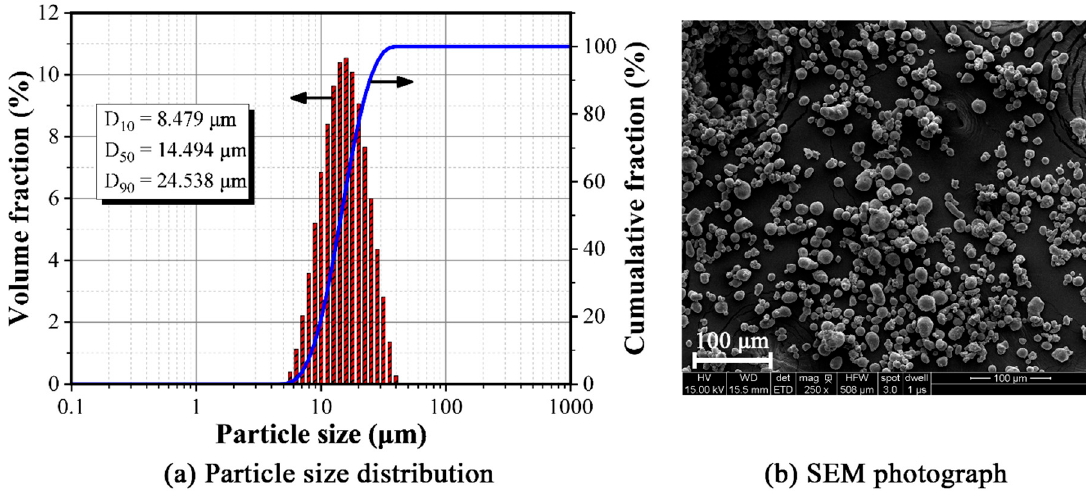
Figure 1. Particle size distribution and SEM photograph of aluminum dust: ( a ) Particle size distribution; ( b ) SEM photograph.